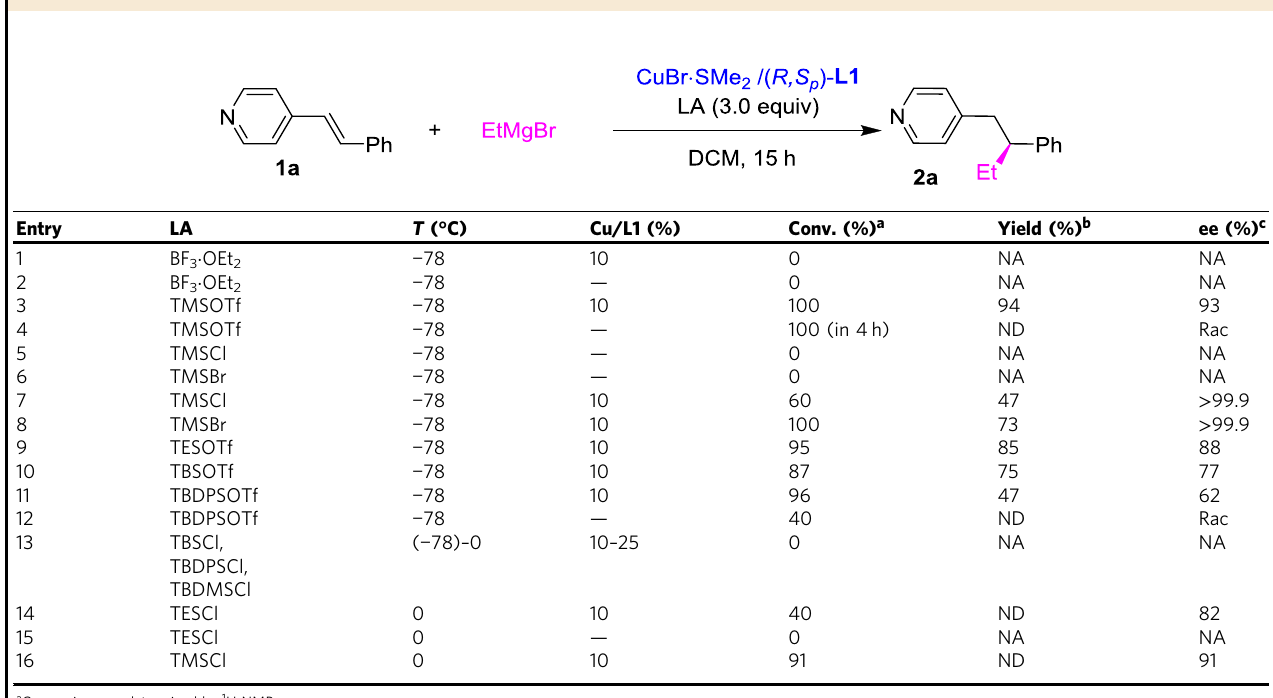
Table 4 Effect of different LAs in Cu(I)-catalysed addition of EtMgBr to